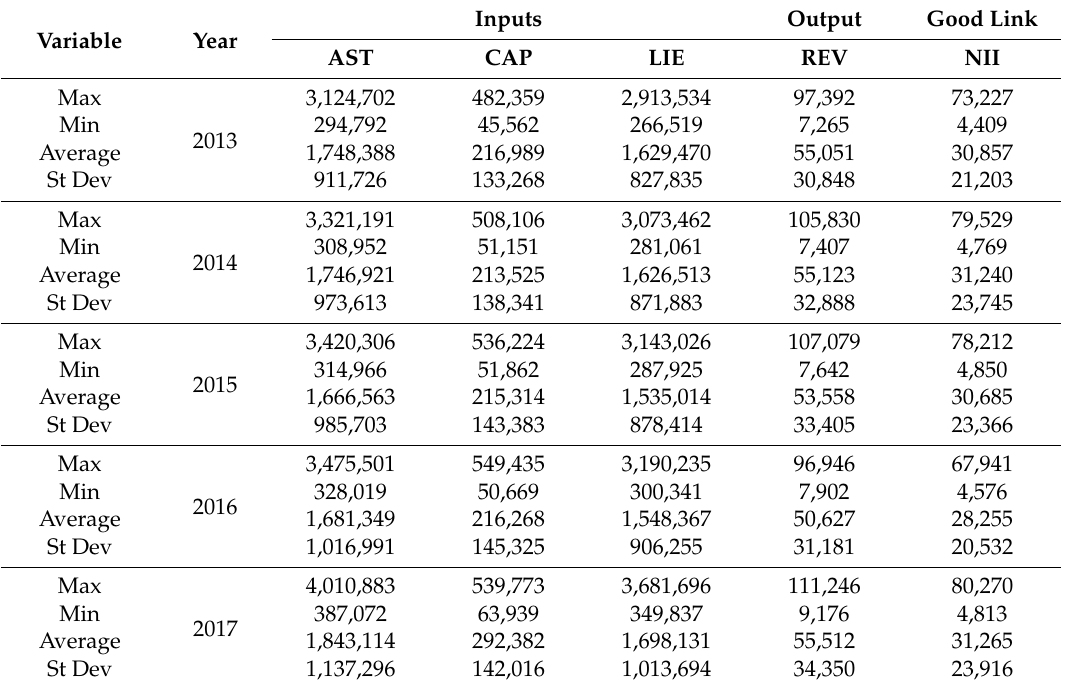
Table A1. Statistics on data (million